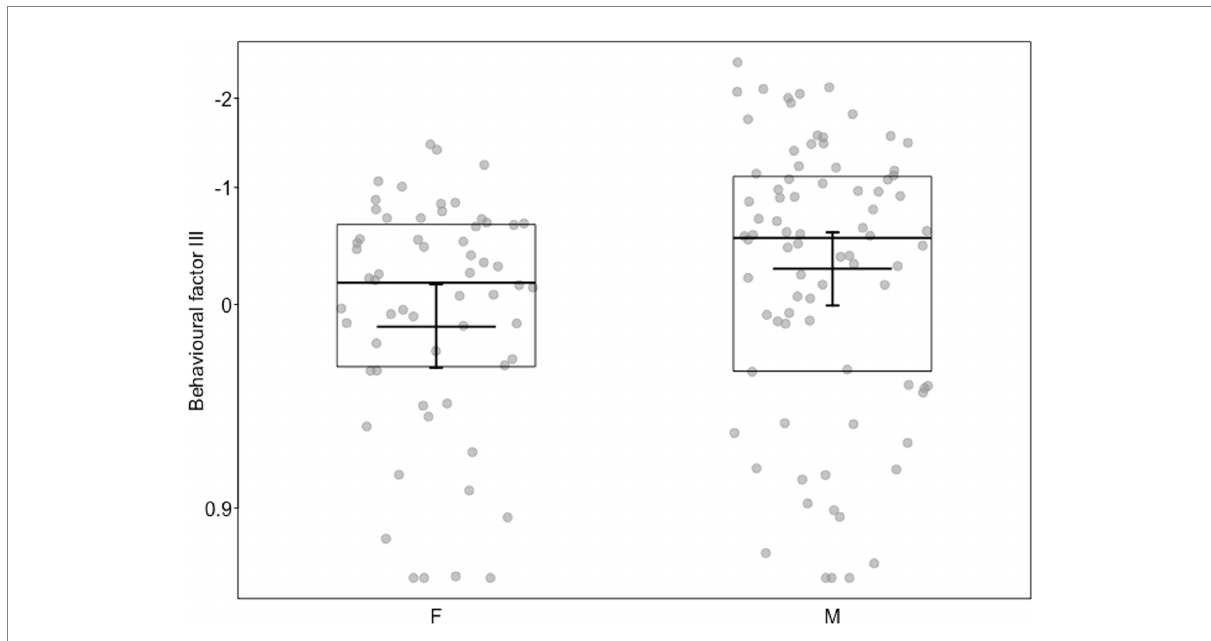
FIGURE 5 Behavioral factor III ( y -axis) as a function of sex ( x -axis; F = female, M = Male). Dots show the individual data, horizontal lines with boxes medians and quartiles, and the short horizontal lines with error bars the fitted model and its confidence limits with all other predictors centered to a mean of zero. Behavioral factor III was mainly correlated with proportion time petting and proportion time staying with